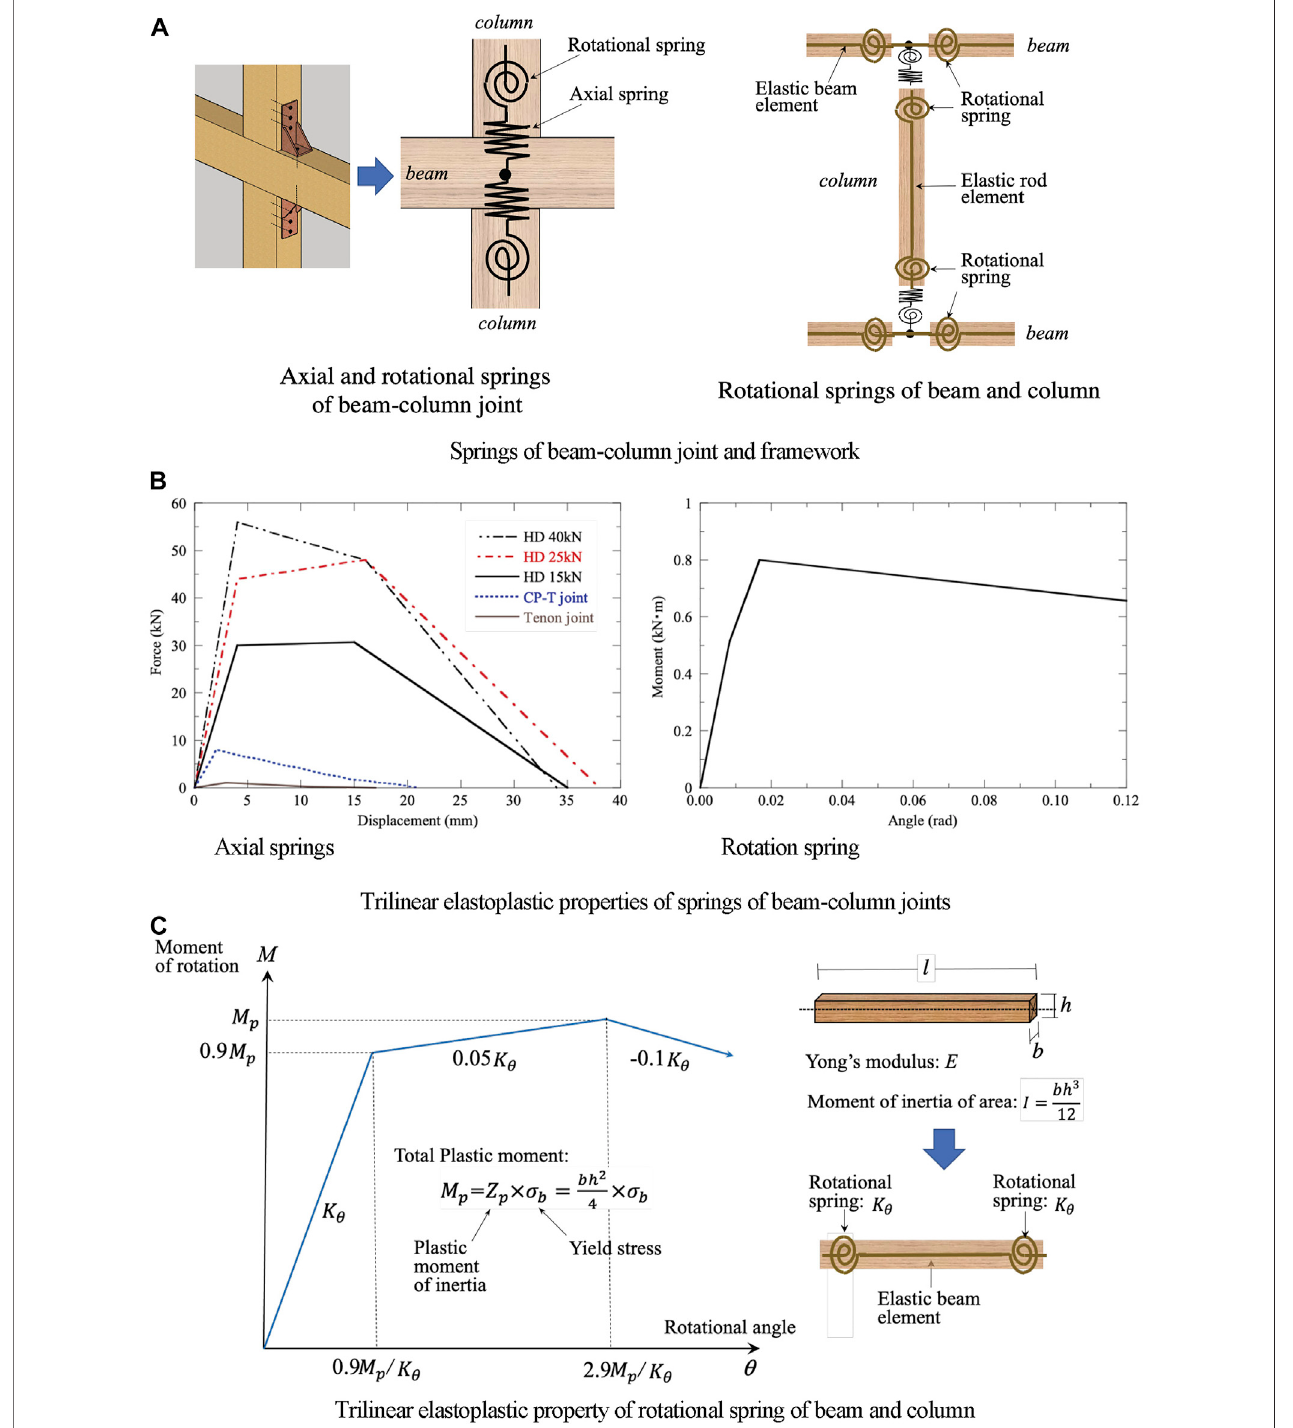
FIGURE 8 | Analytical models of joints and framework. (A) Springs of beam-column joint and framework. (B) Trilinear elastoplastic properties of springs of beam- column joints. (C) Trilinear elastoplastic property of rotational spring of beam and column.